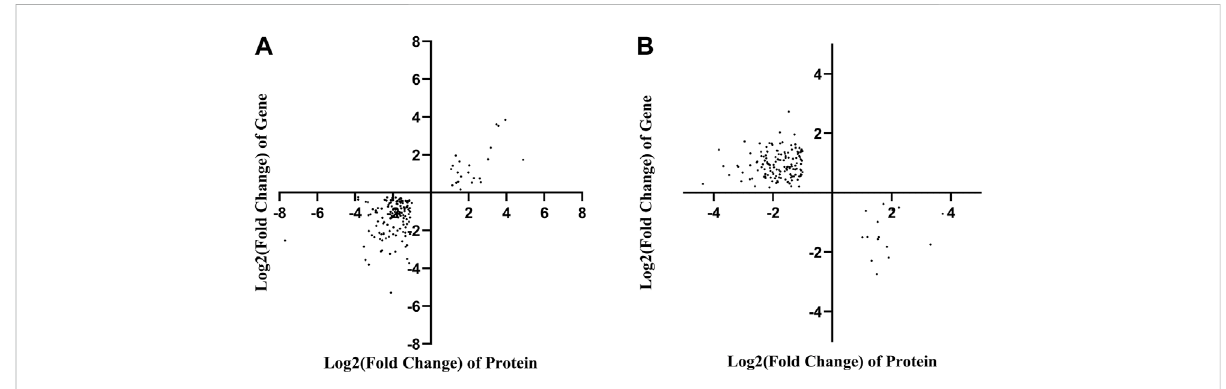
Correlation analysis based on the proteomics and transcriptomics. (A) Correlation analysis of differentially expressed proteins and genes with the same tendency of change. (B) The correlation analysis of signi fi cant differential expression of proteins and genes with opposite